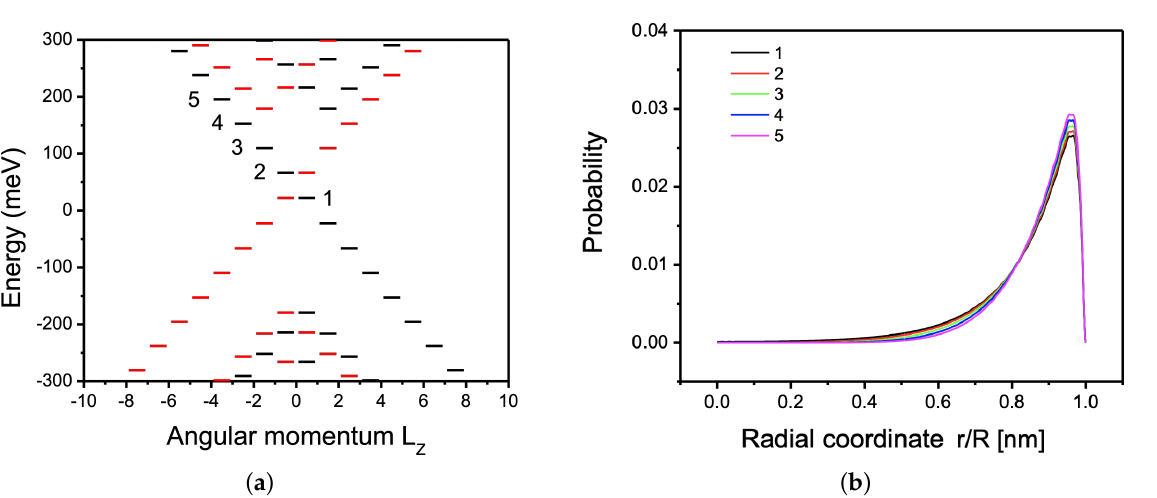
Figure 3. ( a ) Spectrum of energy levels for a disc TI quantum dot as a function of total angular momentum L z = m + S z where m is the orbital angular momentum and S z is the spin for radius R = 167 nm. Red levels correspond to spin down and black levels to spin up. Energy levels in the bulk gap are visible. ( b ) Electronic probability for states 1–5 shown in ( a ). The edge character of gap states and their position with respect to the edge are visible. The Hamiltonian in Equations (12) and (13) is numerically diagonalized with parameters M = − 150 meV, B = 107 meVnm 2 , and v f = 600 meVnm, corresponding to the topological